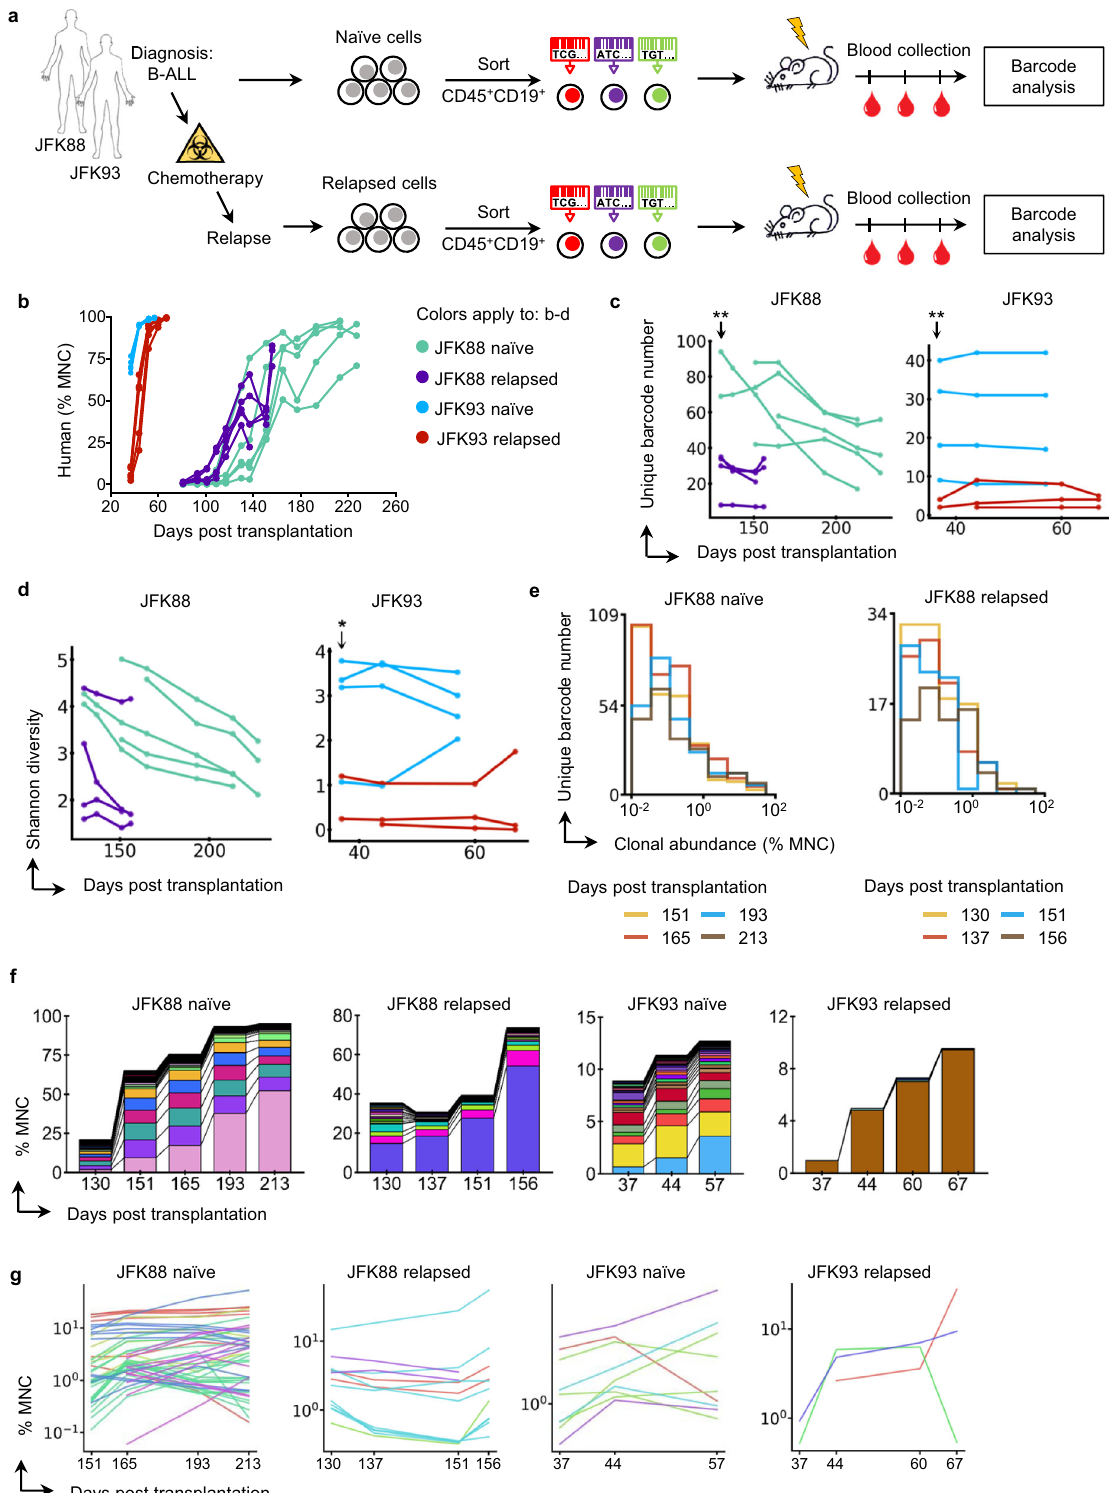
samples from the diagnosis (naïve) stage and after relapse from each of the two patients (Fig. 6a and Supplementary Table 1). The samples from patient JFK93 grew much faster than those from patient JFK88 in vivo (Fig. 6b) and in vitro (Supplementary Fig. 28). Our barcode analysis showed that less than 1% of donor cells engrafted (Supplementary Fig. 29), highlighting the severe